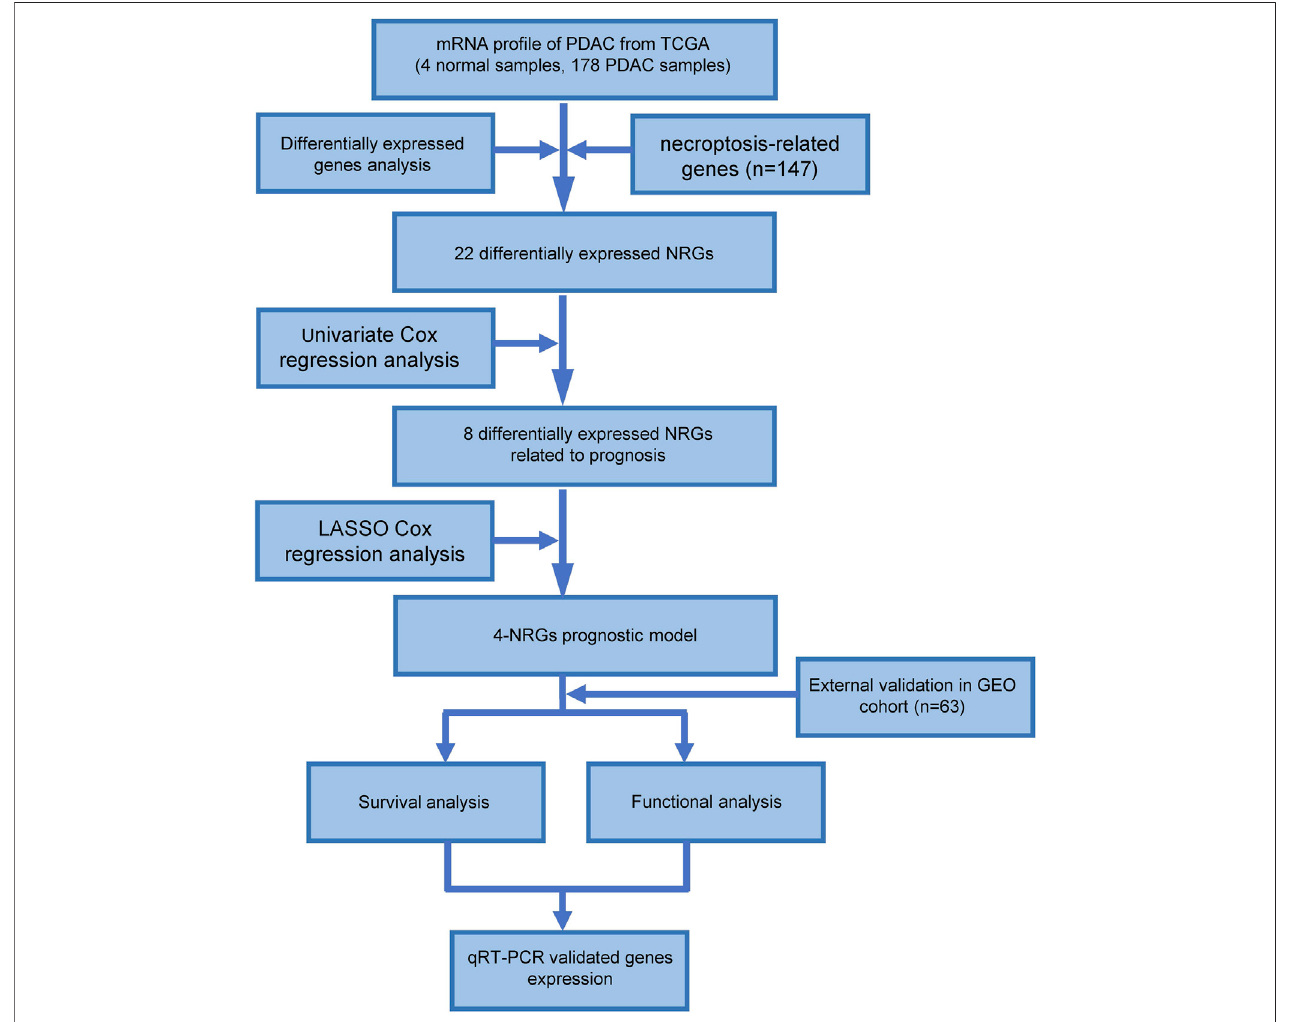
FIGURE 1 | Work fl ow of the